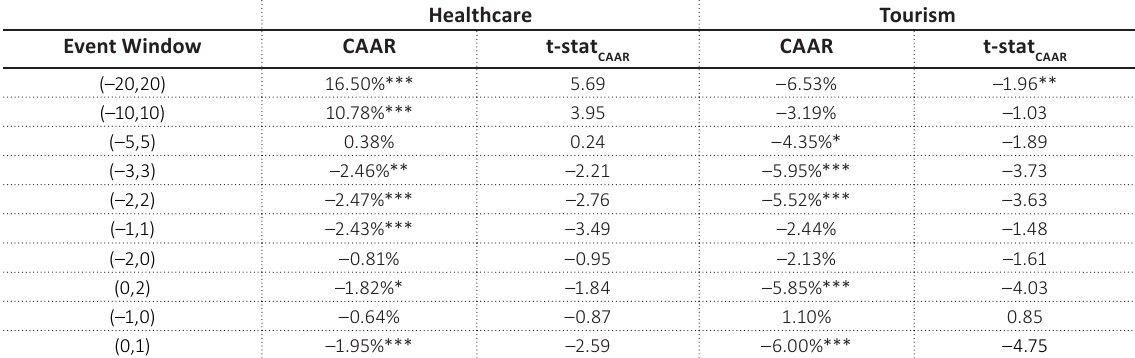
Table 4. Cumulative Average Abnormal Returns of healthcare and tourism sectors surrounding lockdown announcement